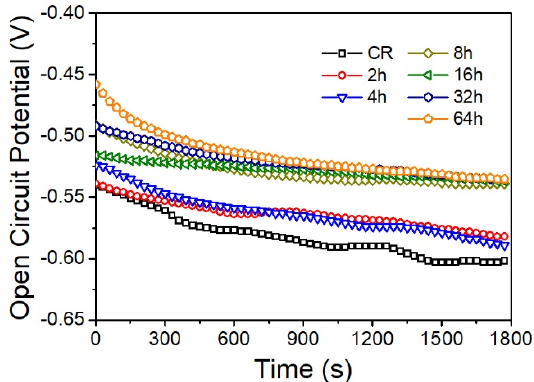
Figure 5. OCP curves of various annealed IF steel specimens.